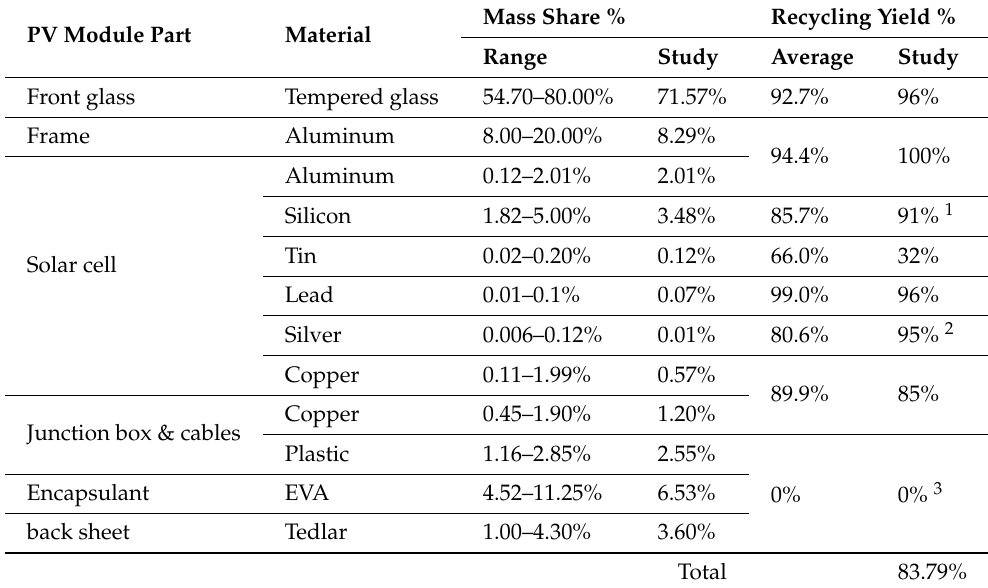
Table 1. Mass composition and recycling yields of materials of c-SI PV